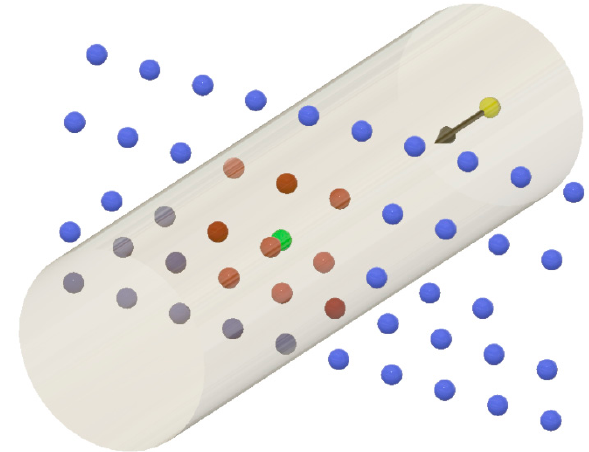
Figure 9. Cylinder traced from one of the mid-surface points (yellow), along its normal vector (black) and the body surface points (blue). The output phantom point (green) was calculated as a center of mass using the range of the scan points (brown) inside the cylinder.